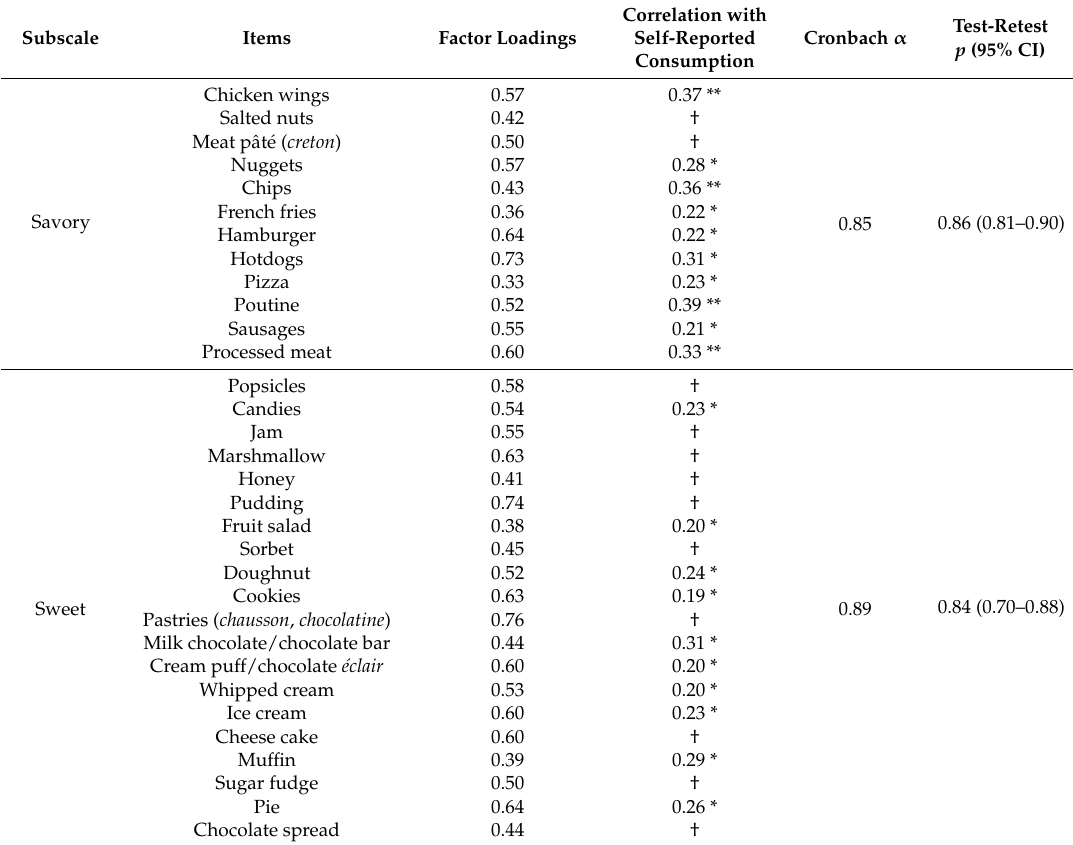
Table 2. Subscales’ items, factor loadings, and results from the concurrent validity, internal consistency reliability, and test-retest